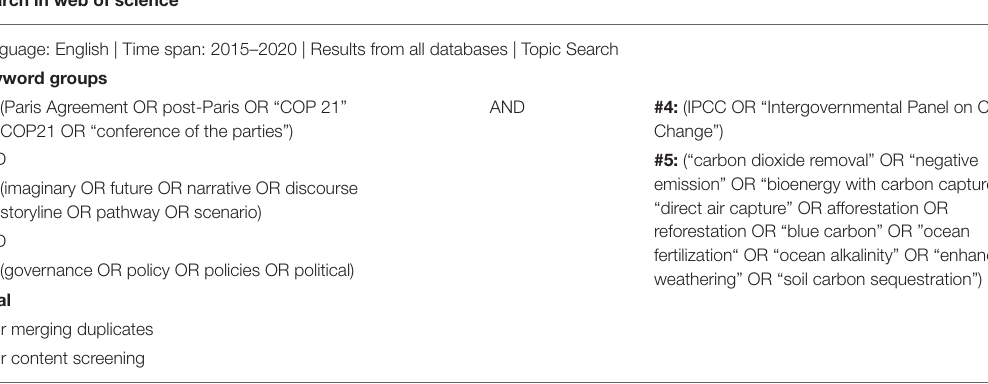
TABLE 1 | Sampling steps literature review. Search in web of